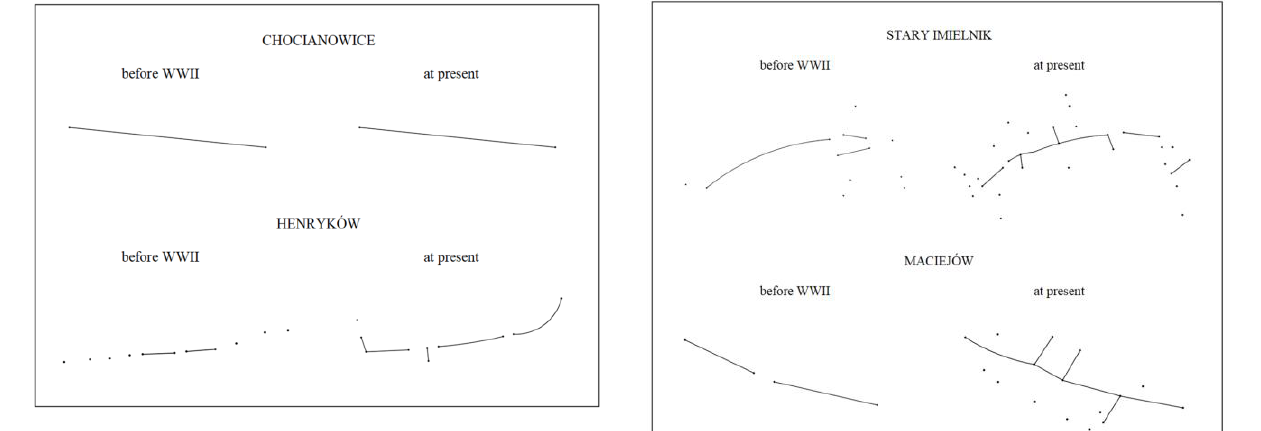
Fig. 4. Graphs depicting the low rank of morphological changes of the former villages Chocianowice and Henryków (in the intra-urban area) (Source: own work)